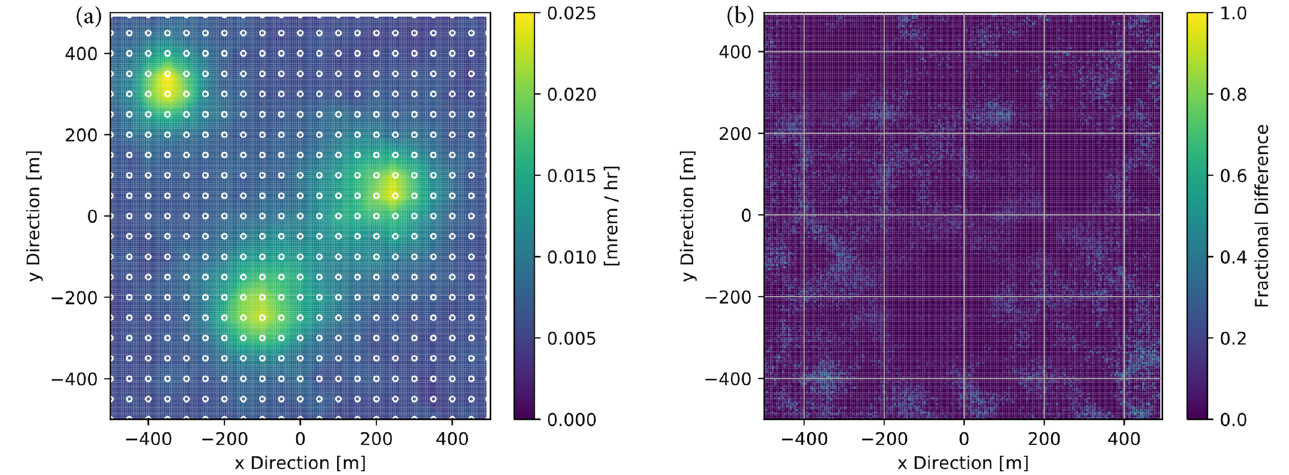
Figure 7. ( a ) Uniform measurement locations with measurements taken every 50 m and linearly interpolated between observation points, and ( b ) the grid-by-grid fractional difference to the true distribution shown in Figure 1. The white markers represent locations where a measurement has been taken.